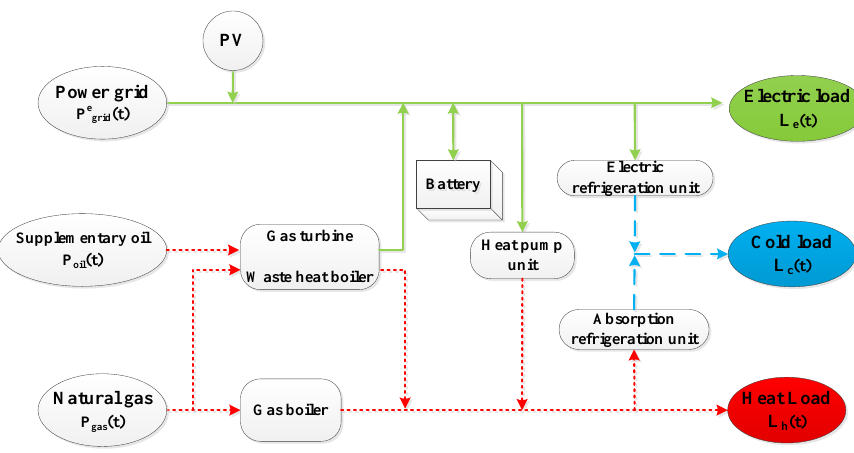
Figure 1. Energy utilization framework of a typical integrated energy park.